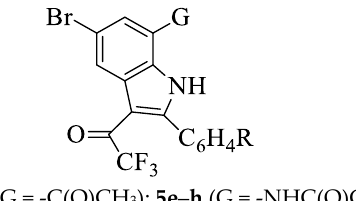
Table 3. IC 50 values of compounds 5a – h against A549 and HeLa cells.